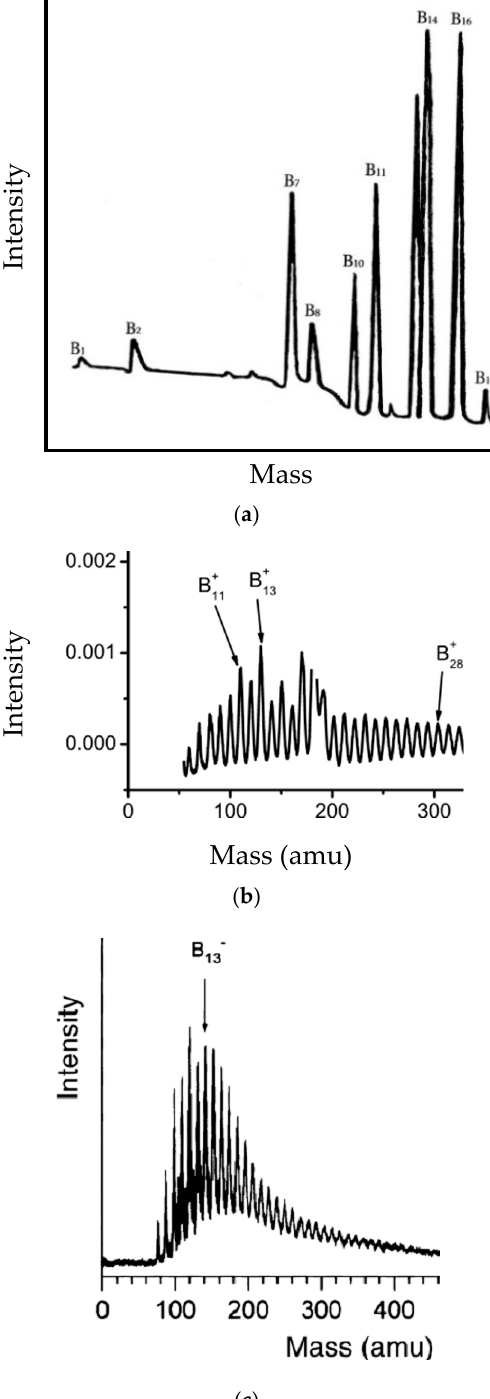
Figure 3. Experimentally recorded mass spectra of ( a ) neutral [130], Copyright (2015), with permission from Authors; ( b ) positively [29], Copyright (2010), with permission from KIT Scientific Publishing; and ( c ) negatively charged [28] boron clusters, Copyright (2003), with permission from Elsevier.